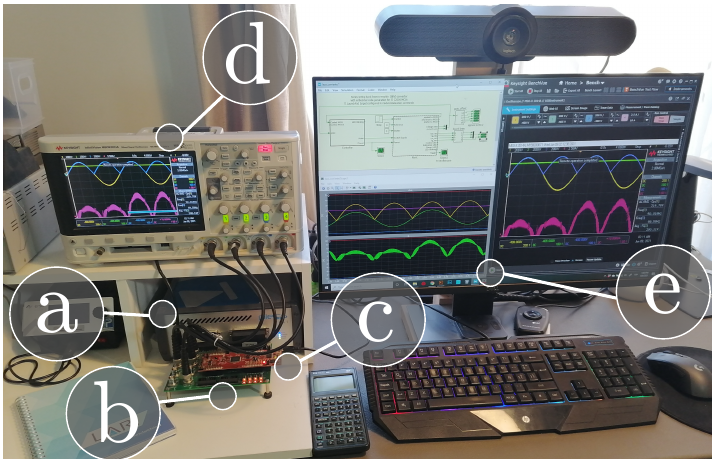
Figure 8. Hardware in-the-loop experimental setup: ( a ) PLECS RT-box , ( b ) RT Box LaunchPad Interface, ( c ) Texas Instruments LAUNCHXL-F28069M, ( d ) oscilloscope, ( e ) computer to program the RT Box and the microcontroller, perform the simulations, and communicate the data with the